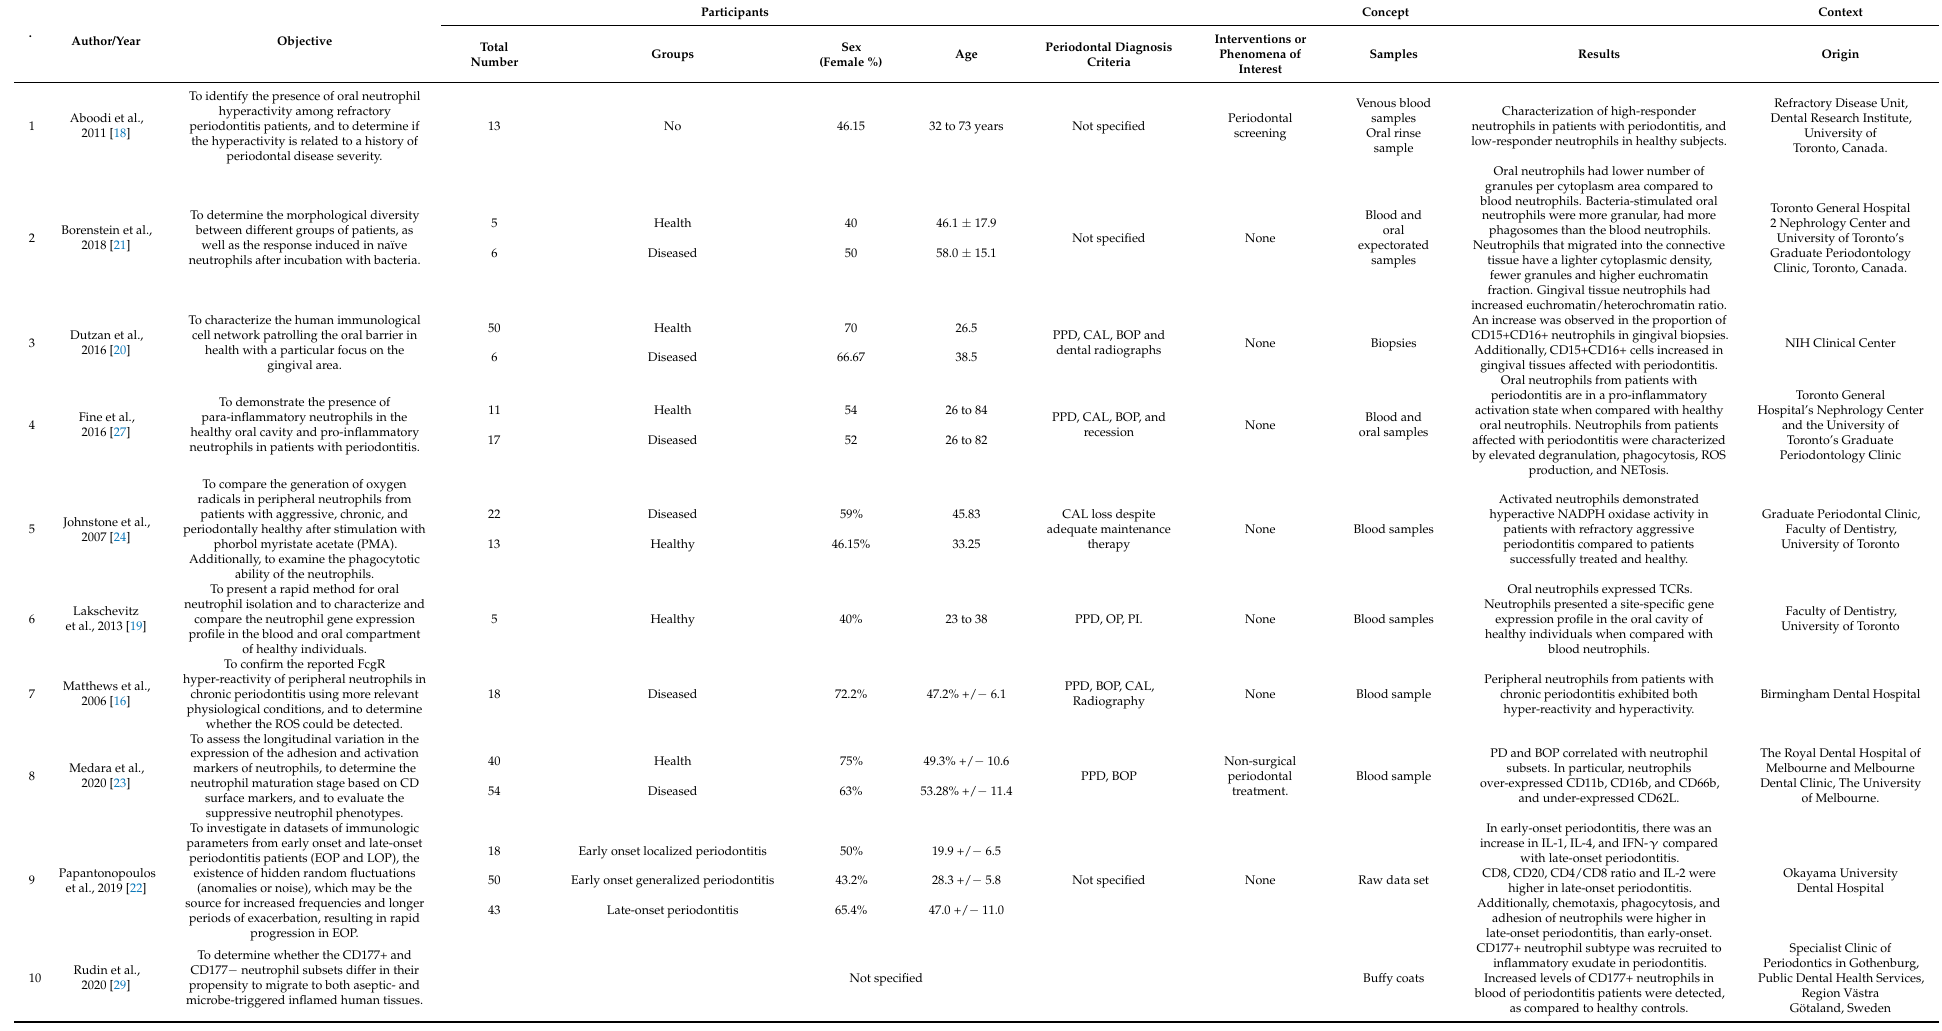
Table 1. Data extracted after individual analysis. Population, concept, and context